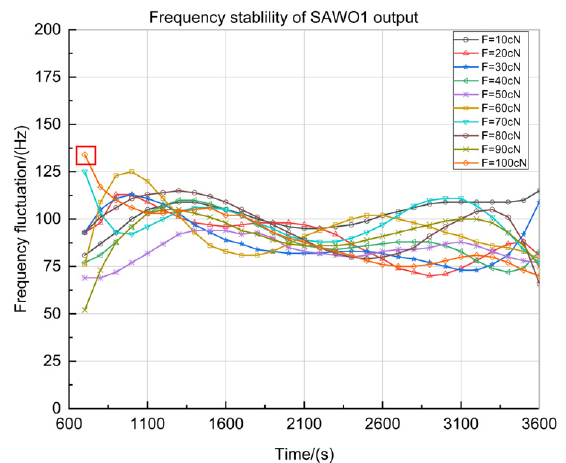
Figure 11. Frequency stability curve of SAWO1 loaded with tension (the red box is the maximum data for all the tests) . Table 3. Frequency fluctuations test data of SAWO1 from 600 s to 3600 s when F = 100 cN (the group where the greatest fluctuation occurred, and the red color is the maximum data for this group of tests) .